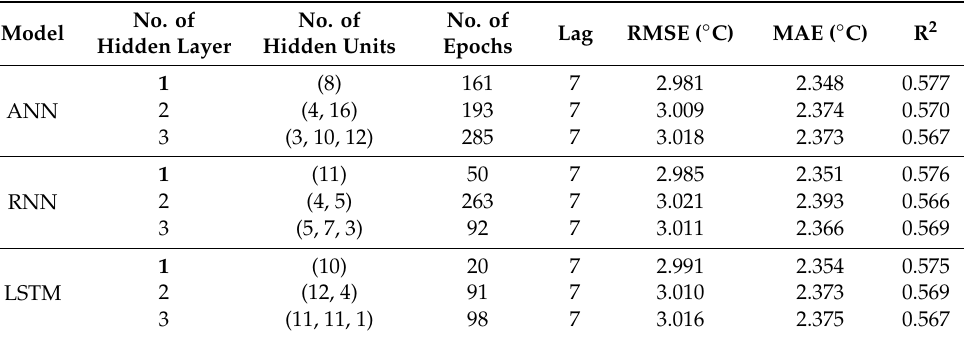
Table 2. The performance measure of models for